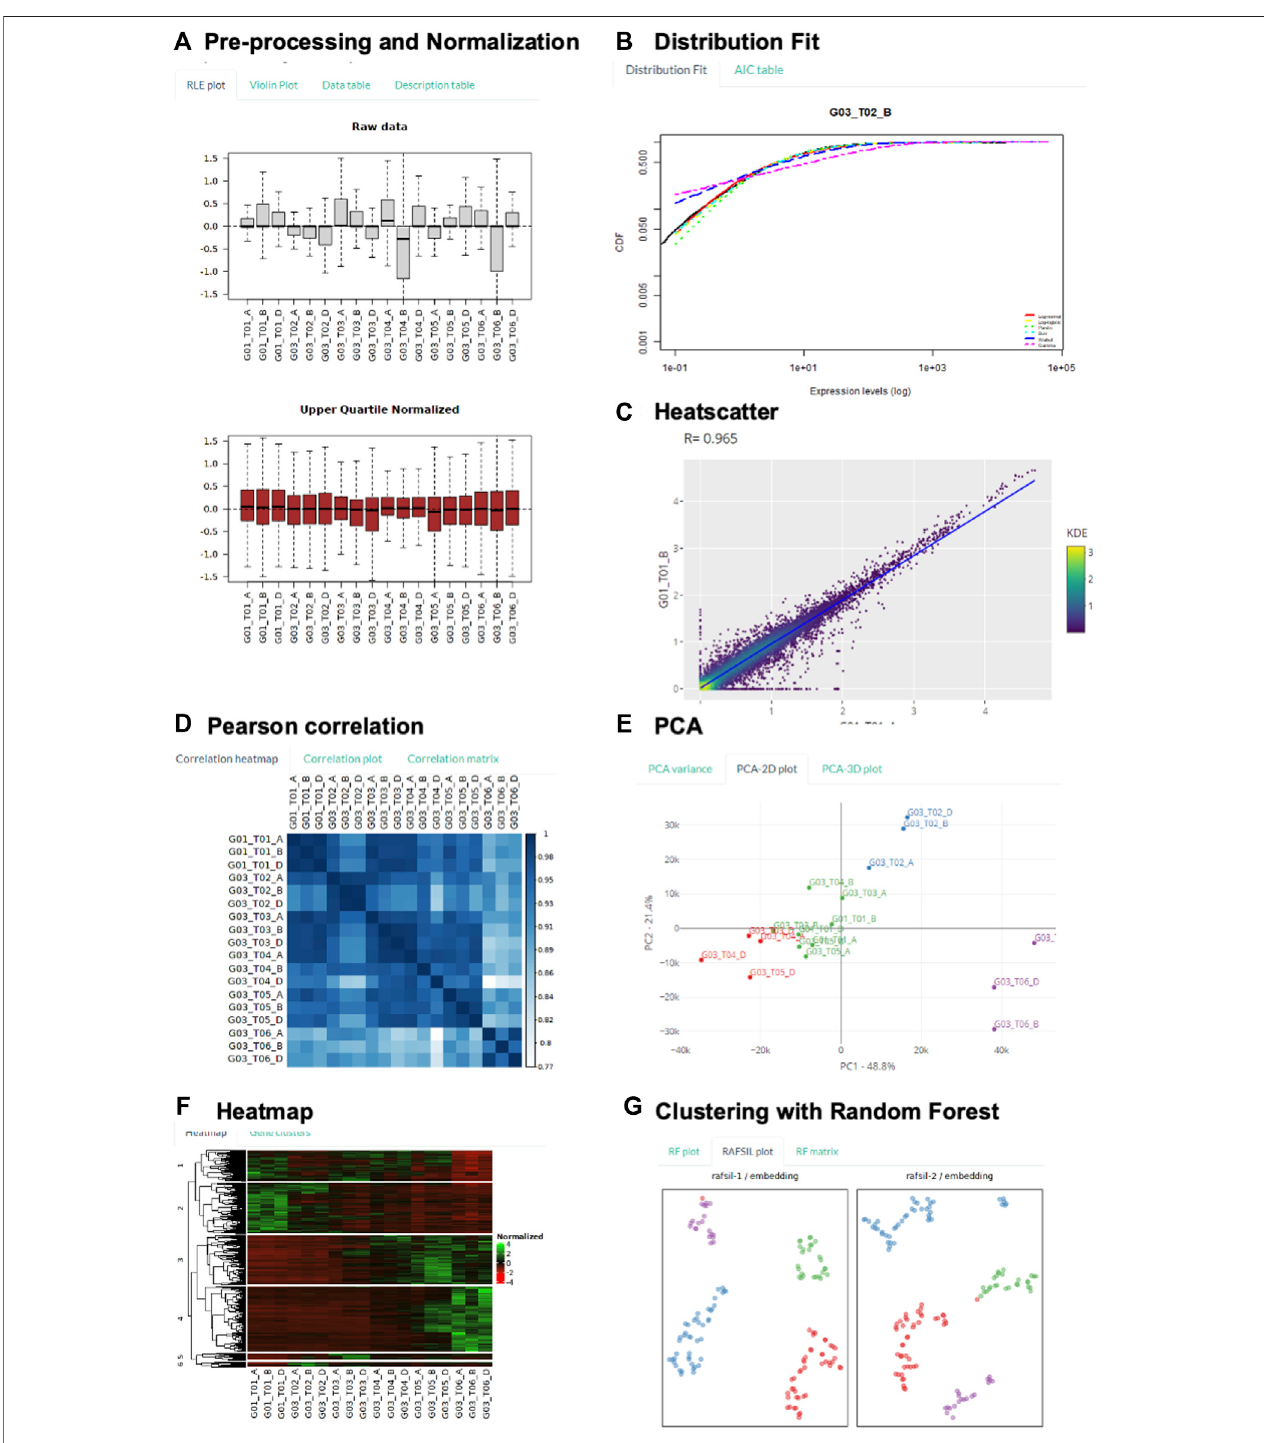
FIGURE3| DemonstrationofKeyTranscriptomicAnalysisusingGeneCloudOmics. (A – F) usingbulk-RNASeqhumanT-regulatorycelldifferentiationdata,and (G) using single-cell RNASeq mouse distal lung epithelium data. (A) : RLE plot of raw and normalized data, showing sample variation reduced after normalization. (B) : Comparing transcriptome-wide distribution with six model distributions to select suitable expression cut-off threshold. (C) : Between-replicate transcriptome-wide variation visualized by scatter plot. (D) : Pairwise Pearson correlation between all samples. (E) : Principal component analysis visualizes all sample data points in 2 dimensions. (F) :HierarchicalclusteringrevealscommonexpressionpatternsthroughouttheTcelldifferentiationprocess,visualizedbyheatmapofexpressionlevel. (G) : Random Forest clustering divides single cells according to their developmental stages.